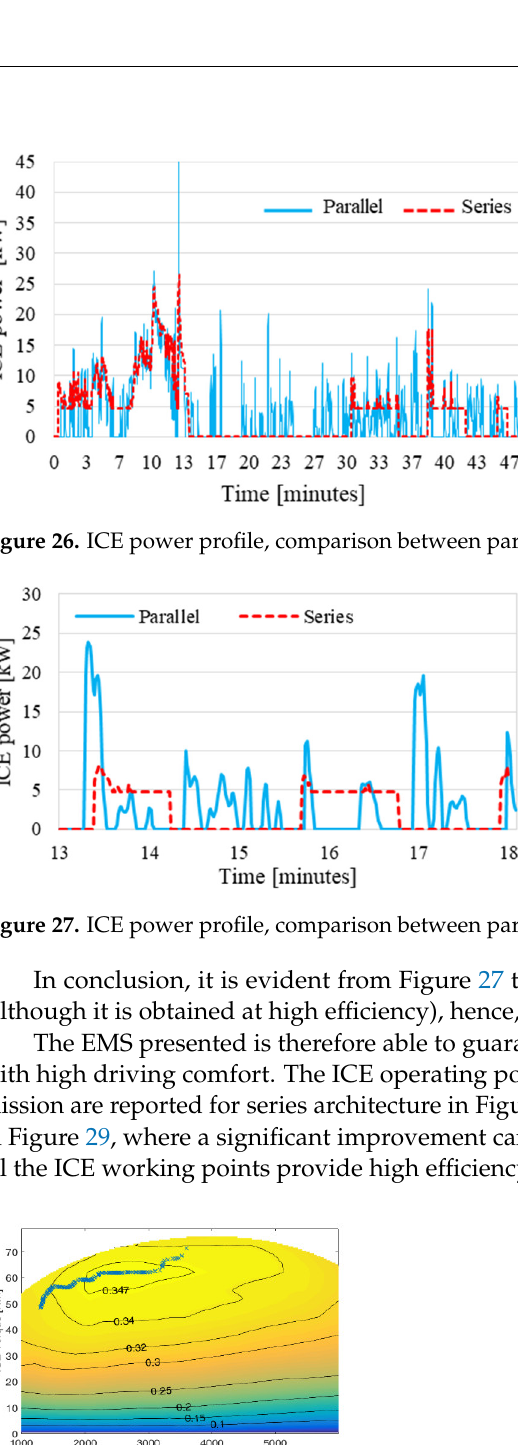
Figure 26. ICE power profile, comparison between parallel and series architectures (Extra-urban).